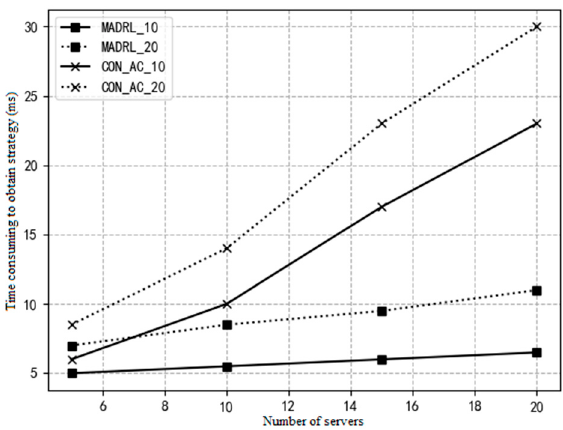
Figure 4. Time needed to obtain migration strategy in different number of servers.